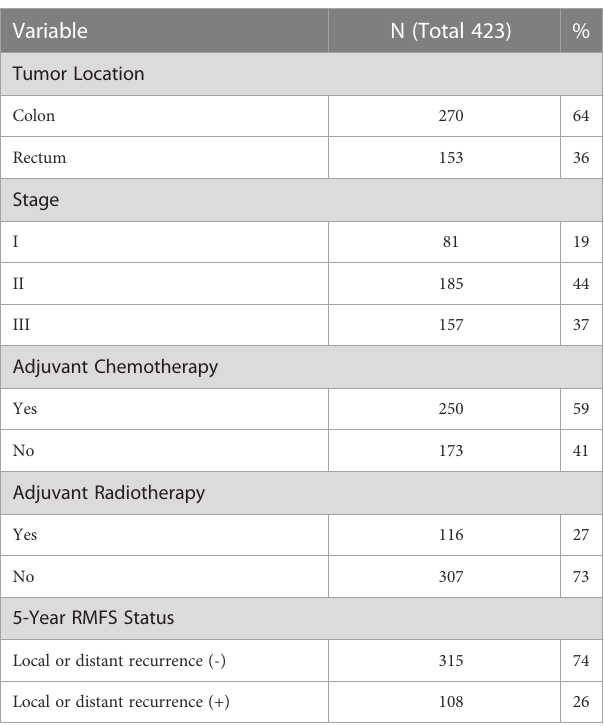
TABLE 1 Baseline characteristics of the patient cohort included in the GMDR and logistic regression analysis.